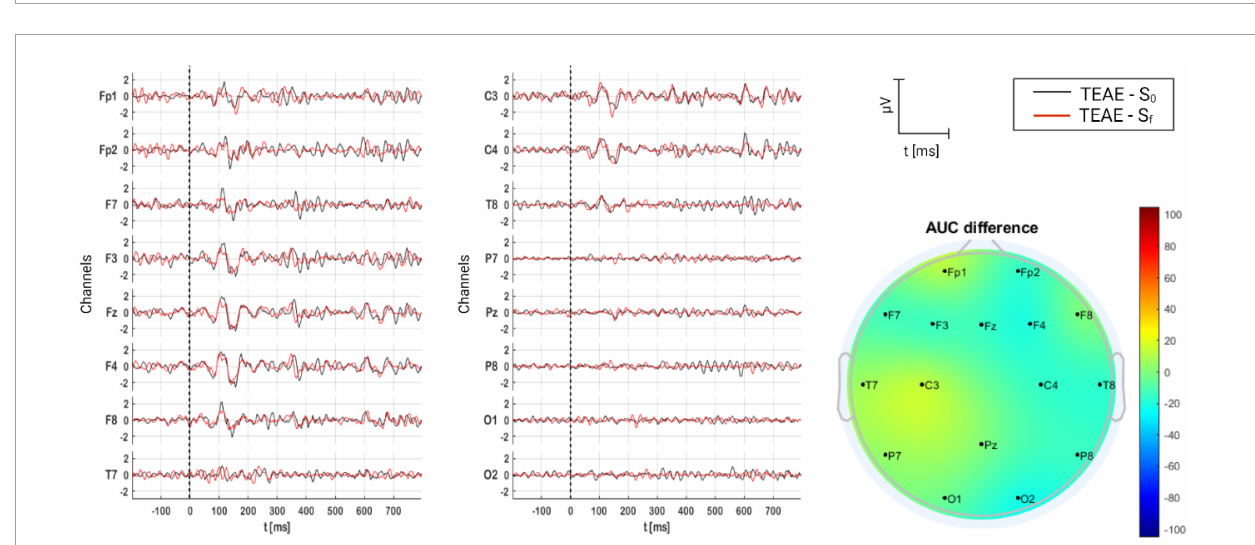
FIGURE10 Grand average of AERPs at S 0 (initial session) and S f (final session) for TEAE group. In addition, the AUC difference of these two grand averages (S f – S 0 ) is topographically plotted in µ